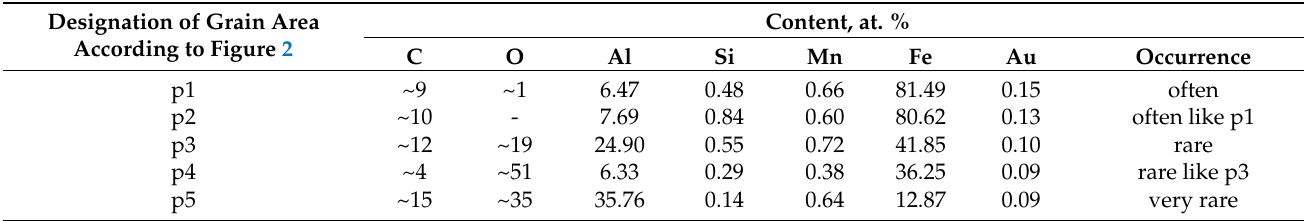
Figure 2. Microstructure of arc-sprayed Fe-Al-type intermetallic coating after annealing at 700 ◦ C for 2 h with hypothetical phase identification based on results of EDS point analysis (in Table 1). Table 1. Chemical composition of as-arc-sprayed Fe-Al-type coating after annealing at 700 ◦ C/2 h based EDX point microanalysis according to Figure